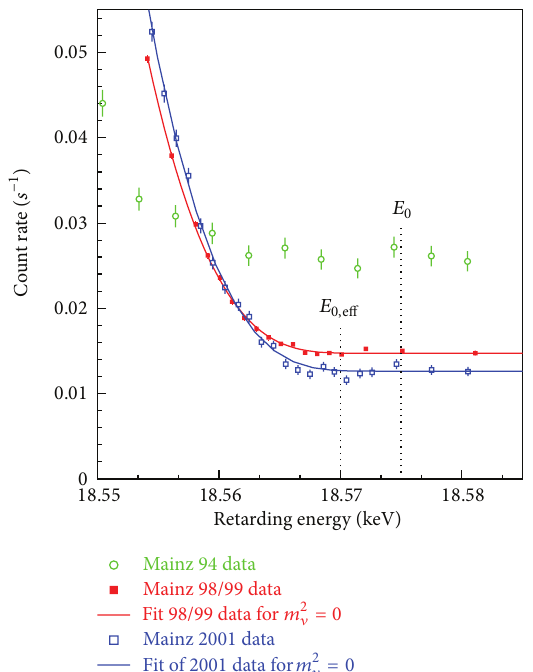
Figure 11: Averaged count rate of the Mainz 1998/1999 data (filled red squares) with fit for 𝑚(𝜈 𝑒 ) = 0 (red line) and of the 2001 data (open blue squares) with fit for 𝑚(𝜈 𝑒 ) = 0 (blue line) in comparison with previous Mainz data from 1994 (open green circles) as a function of the retarding energy near the endpoint 𝐸 𝐸 0 and effective endpoint 0, eff (taking into account the width of the response function of the setup and the mean rotation- vibration excitation energy of the electronic ground state of the ( 3 HeT ) + daughter